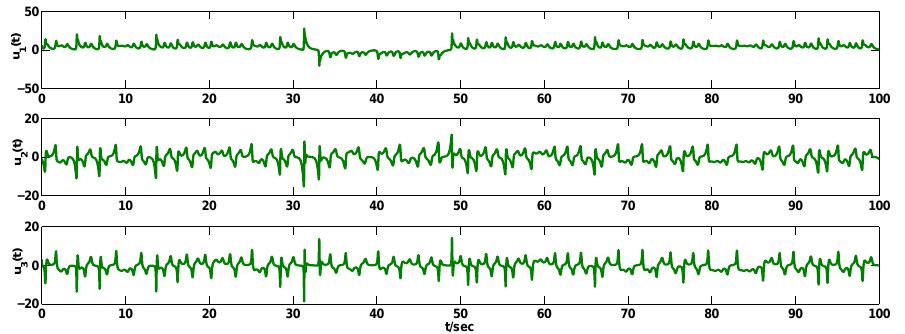
Figure 2. Time response of the states u 1 ( t ) , u 2 ( t ) , u 3 ( t ) of the drive system (13) with fractional order q =